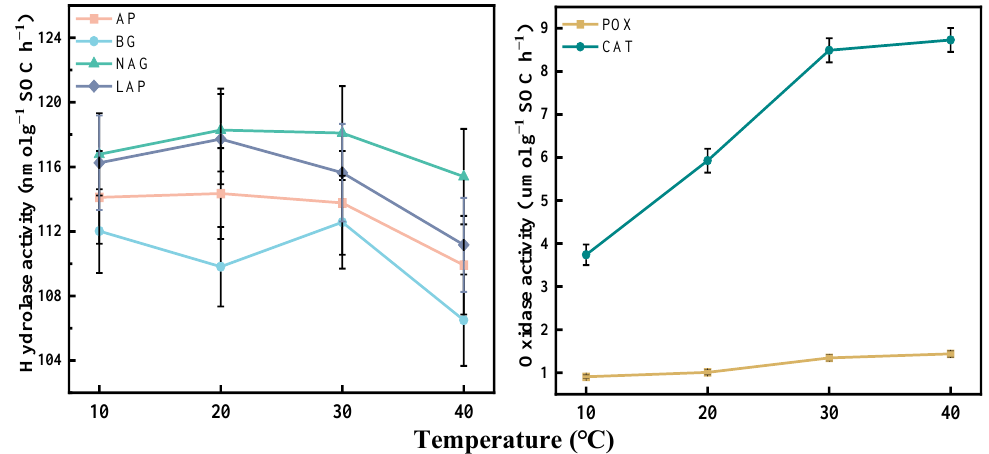
Figure 3. Changes in the activity of six enzymes in Wuzhishan National Nature Reserve at different incubation temperatures. Four hydrolytic enzymes are shown on the left and two oxidative enzymes are shown on the right. The vertical black line represents the standard error. The value of 10 means assay temperature = 10 ◦ C, 20 means assay temperature = 20 ◦ C, 30 means assay temperature = 30 ◦ C, and 40 means assay temperature = 40 ◦ C. Table 2. The Q 10 value of six enzymes in Wuzhishan National Nature Reserve under three forest types, four slope orientations, and four vegetation types. The numbers are means ± standard error. The letters in lowercase indicate significantly different groups based on Duncan’s multiple comparison ( p =